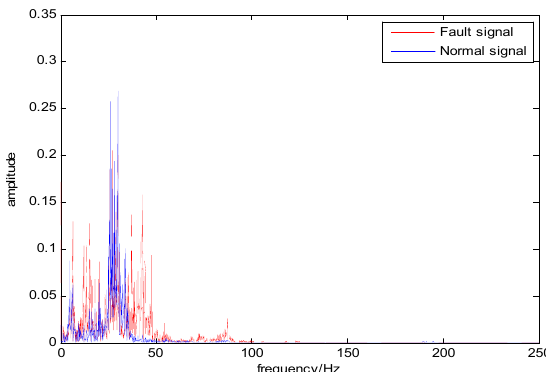
Figure 5. Normal and fault data in the frequency domain.